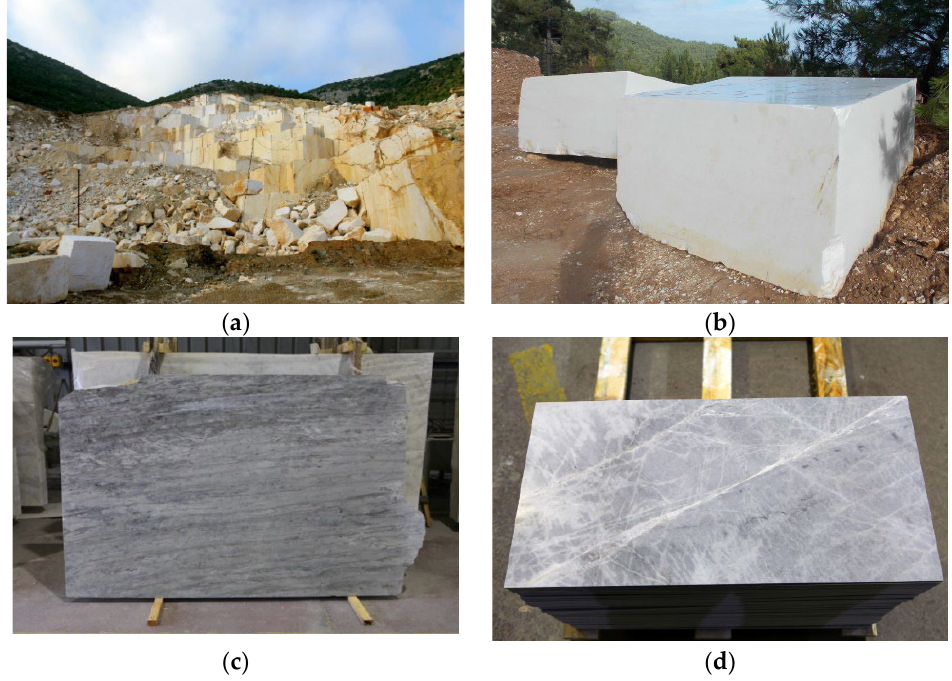
Figure 2. ( a ) A quarry at Paggaion Mountain, Kavala, Greece; ( b ) two blocks of white marble originating from Thassos Island, Greece; ( c ) a marble slab; ( d ) a tile of Grey Lais dolomitic marble from Falakron Mountain, Drama,